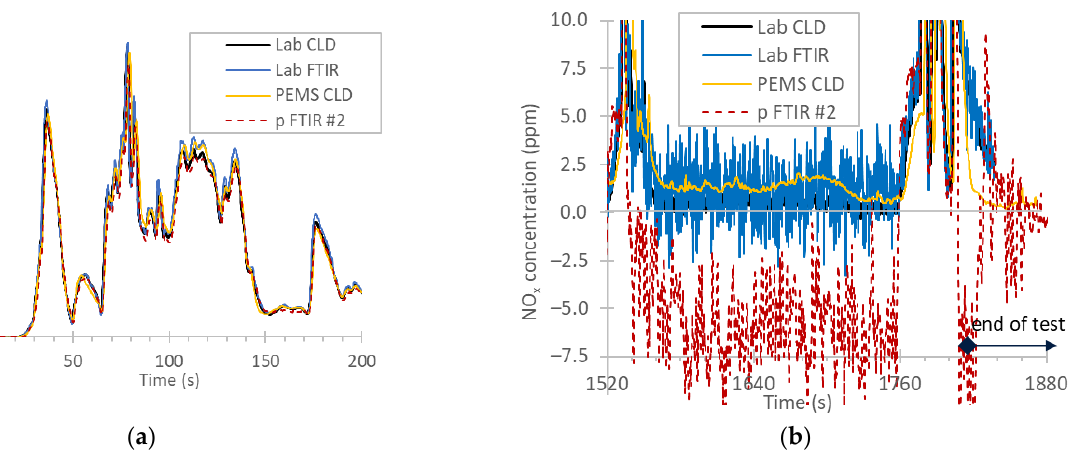
Figure 3. Real time NO x concentrations of the CNG engine: ( a ) first seconds of a cold start WHTC; ( b ) last seconds of a hot start WHTC with reduced scale to low concentrations. CLD = chemiluminescence detection; CNG = compressed natural gas engine; FTIR = Fourier transform infrared; p = portable; PEMS = portable emissions measurement system; WHTC = world harmonized transient cycle.